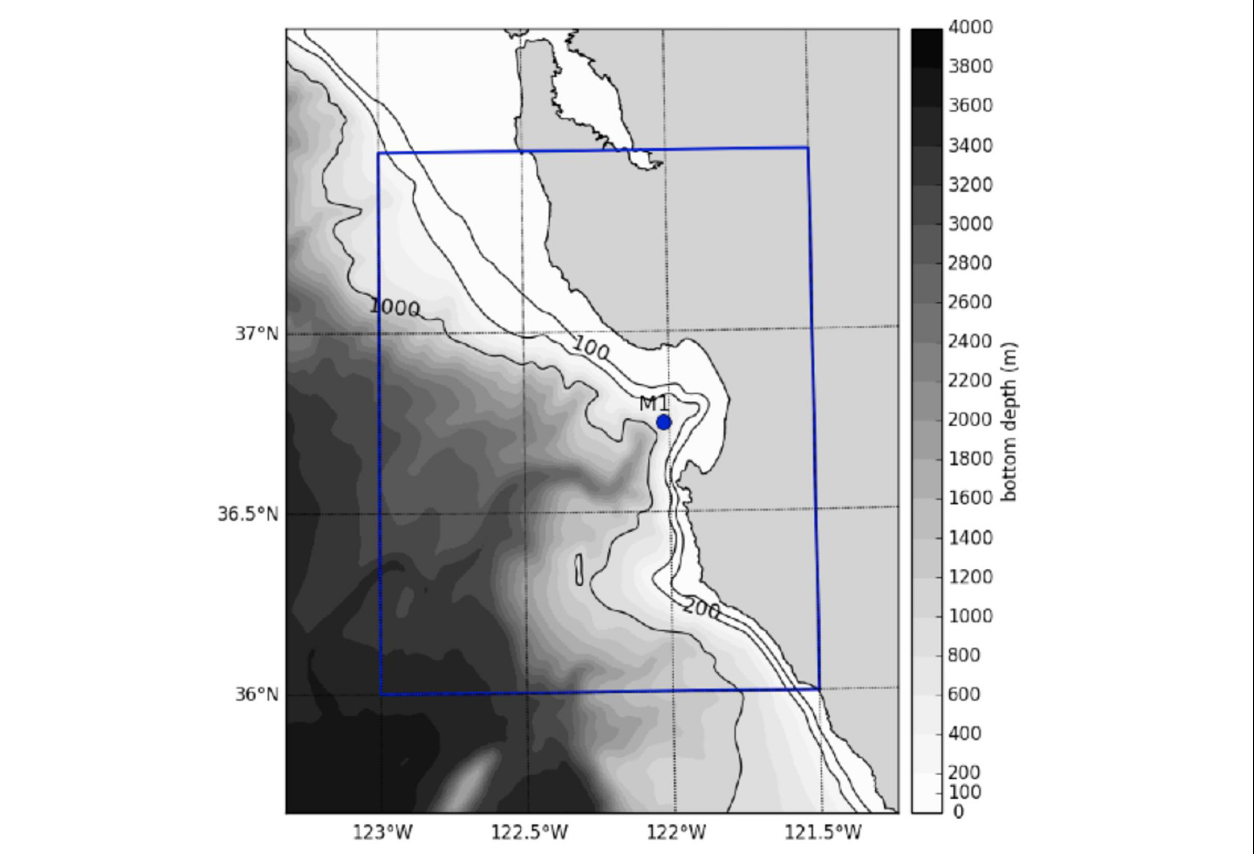
Figure 6 . The bathymetry represents that of the ROMS